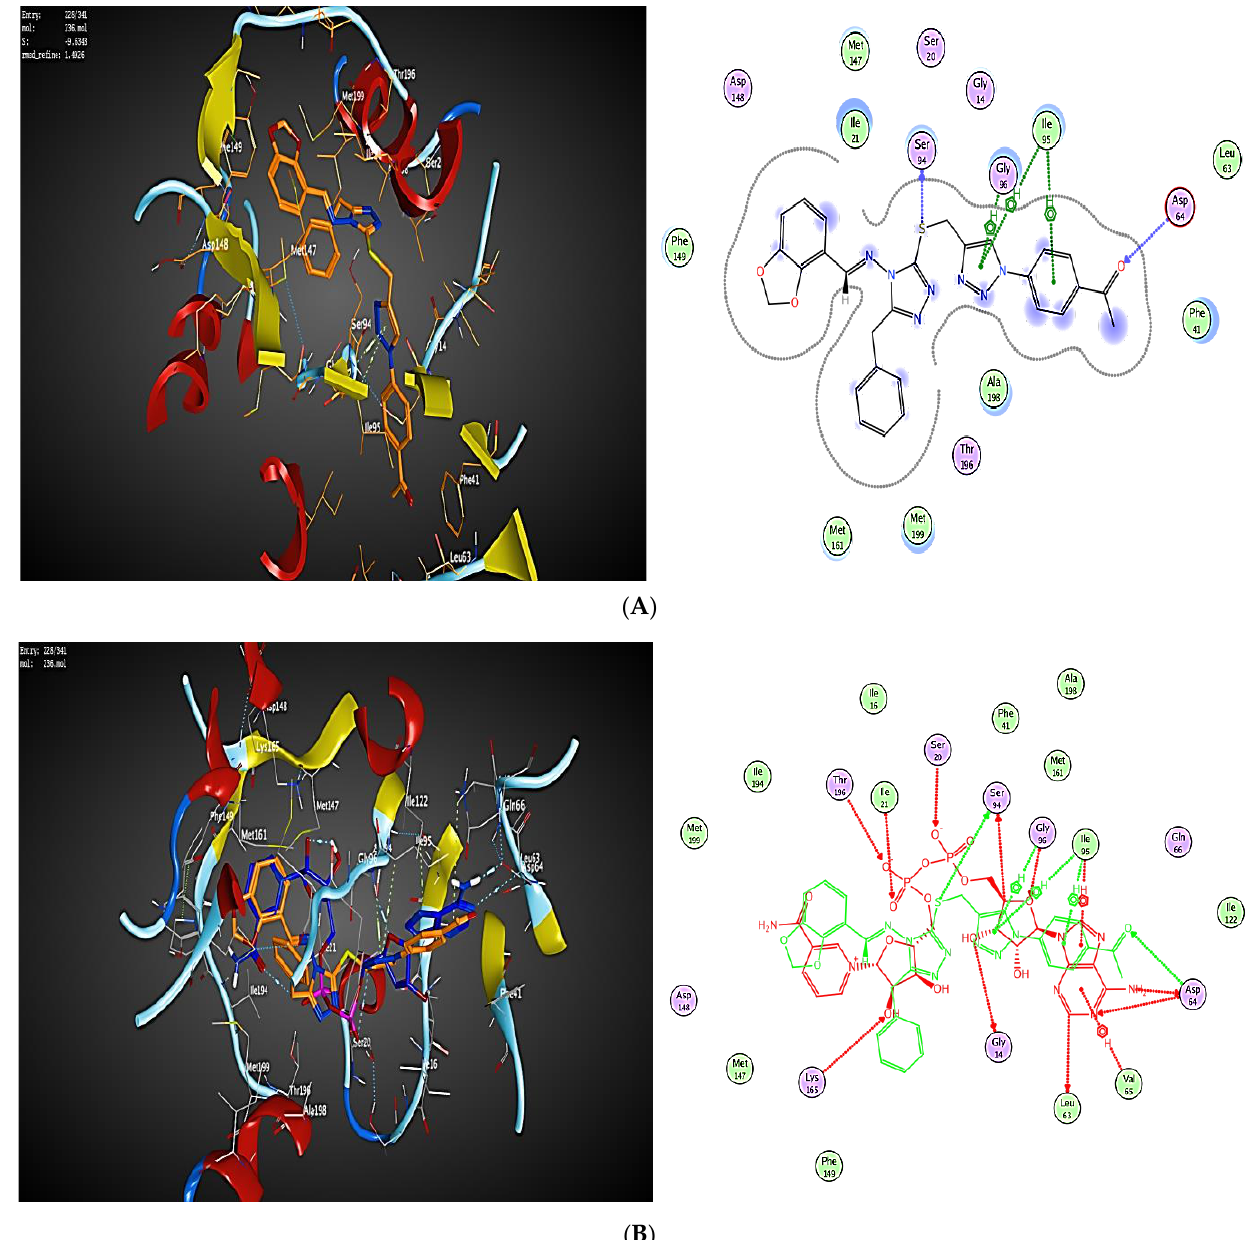
Figure 7. ( A ): Docking and binding pattern of compound 7e into inhA active site (PDB ID: 4TRO) in 2D (right panel) and 3D (left panel). ( B ): An overlay of the docked pose of compound 7e (brown) with the co-crystallized ligand (purple) into inhA active site in 2D (right panel) and 3D (left panel). With regard to compound 7d , which showed (S) − 9.63 kcal/mol and (RMSD) of 1.49, H-bonding observed carbonyl component yl)phenyl(Ethan-1-one of 3.63 Å and the Asp64. The complex formed was further stabilized was further stabilized by two hydrophobic interactions of 3.96 and 4.62 Å between the by two hydrophobic interactions of 3.96 and 4.62 Å between the previous moiety and previous moiety and Gly96 and Ile95, respectively. This is in addition to the hydrogen Gly96 and Ile95, respectively. This is in addition to the hydrogen bond of 3.24 Å that existed bond of 3.24 Å that existed between the 3-thio atom in the methylene thio linker and between the 3-thio atom in the methylene thio linker and Ser94 (Figure 8A,B). Ser94 (Figure 8A,B).